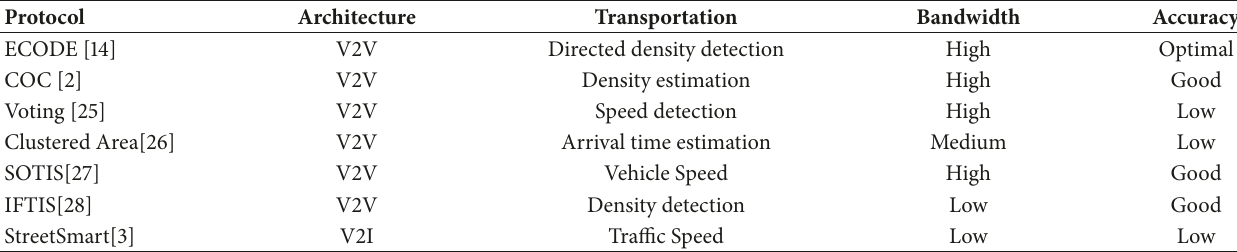
Table 1: Highway traffic monitoring